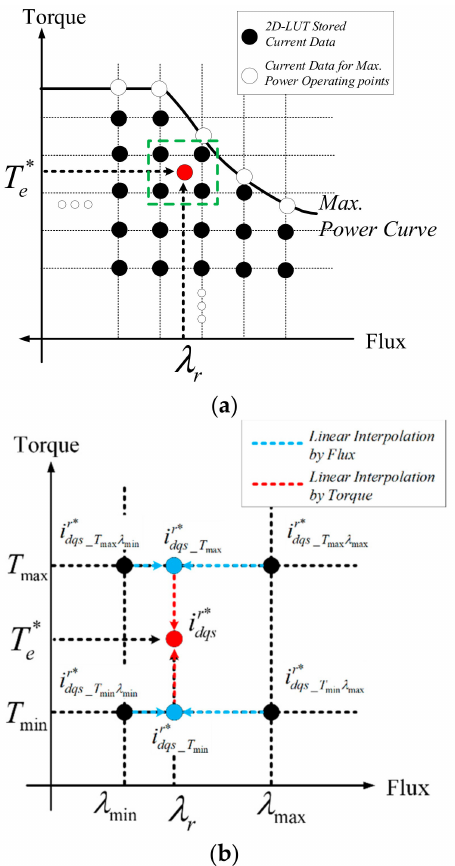
Figure2. Two-dimensionalinterpolationprocedureforcurrentreferencesoutputsfromtwo-dimensional look-up tables (2D-LUT). ( a ) Stored data in the 2D-LUT according to each speed and torque value. ( b ) The 2D interpolation procedure for specific speed and torque reference